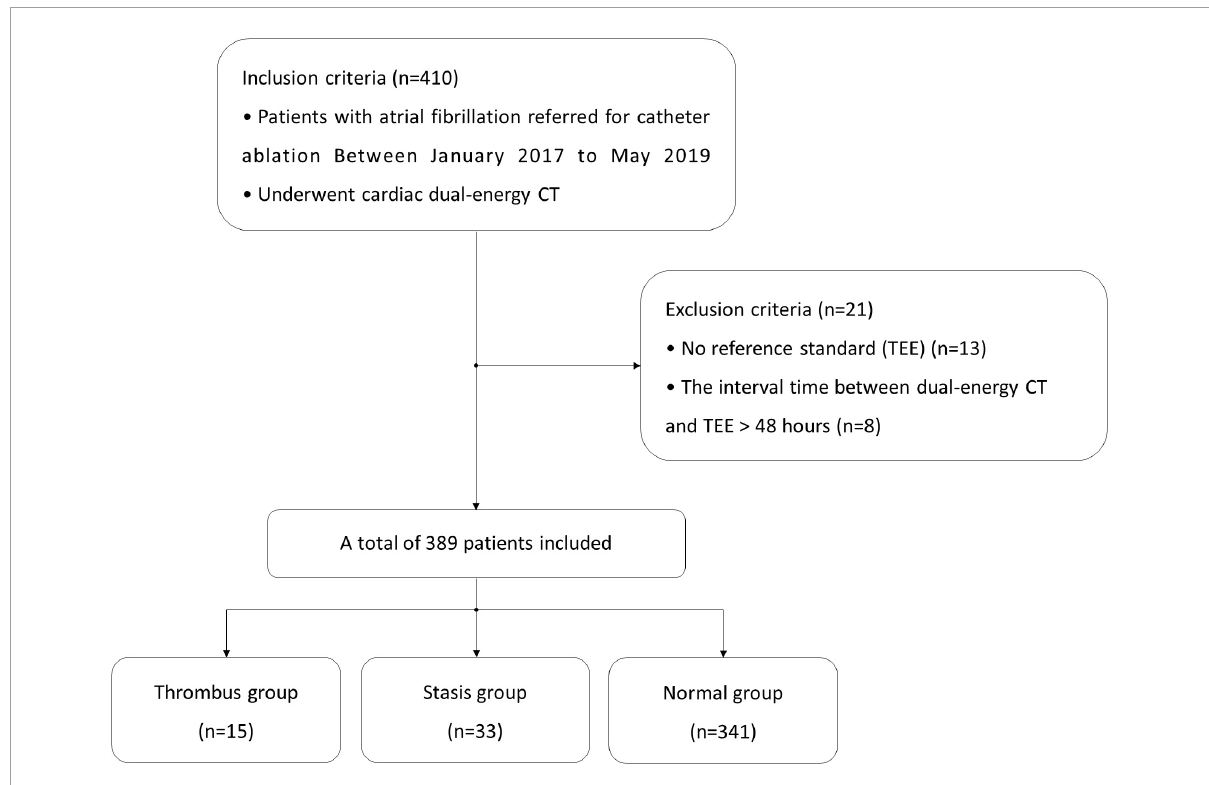
FIGURE1 Flowchart for patient